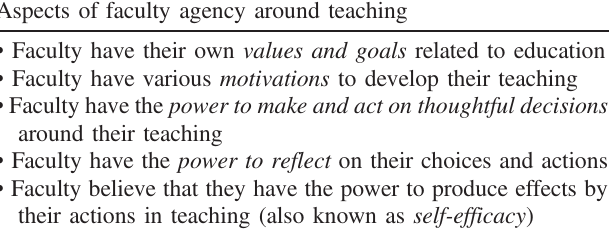
TABLE II. Aspects of faculty agency around teaching,